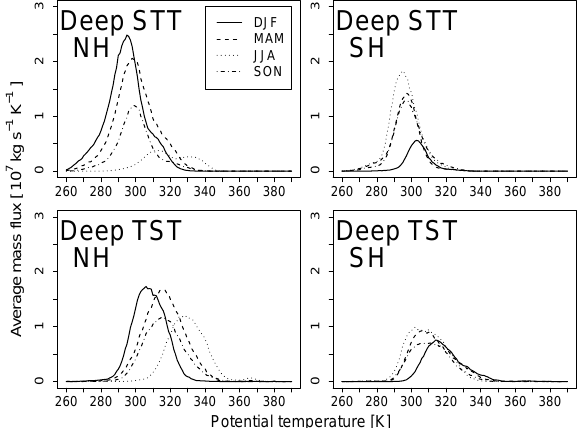
Fig. 11. Potential temperature distribution for deep STT (top) and deep TST (bottom) in the NH (left) and SH (right) averaged from 1979 to 2011. The seasons are indicated by different line patterns as listed in the legend.